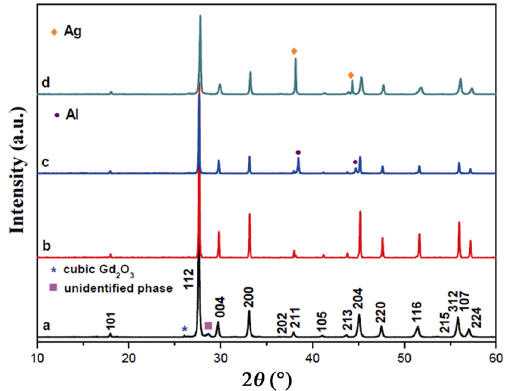
Fig. 3 XRD patterns of Pb 1–3 x (cid:0) x Gd 2 x (MoO 4 ) 1–3 x (WO 4 ) 3 x ( x = 0.0839) samples sintered at (a) 573 K, (b) 1173 K for 2 h, and co-fired materials with (c) 30 wt% Al and (d) 30% wt% Ag at 873 K for 4